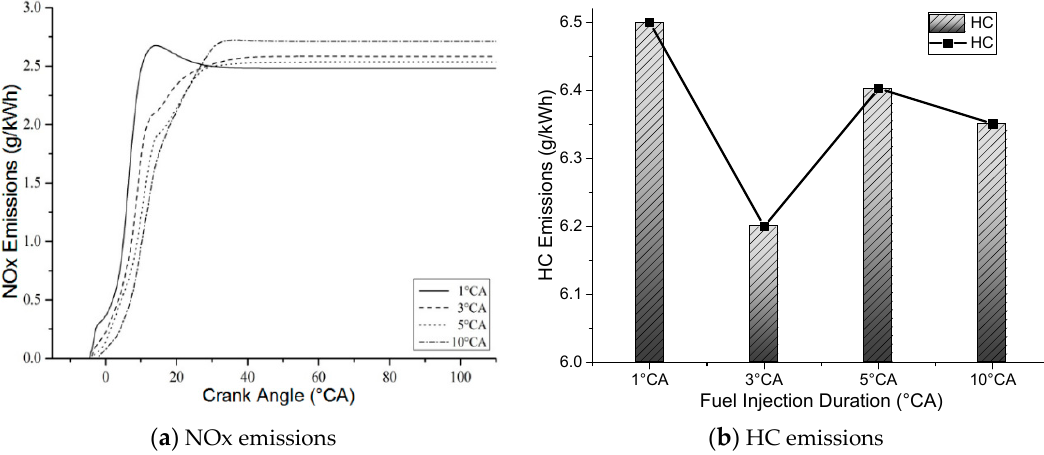
Figure 22. NOx and HC emissions under different pilot injection durations.